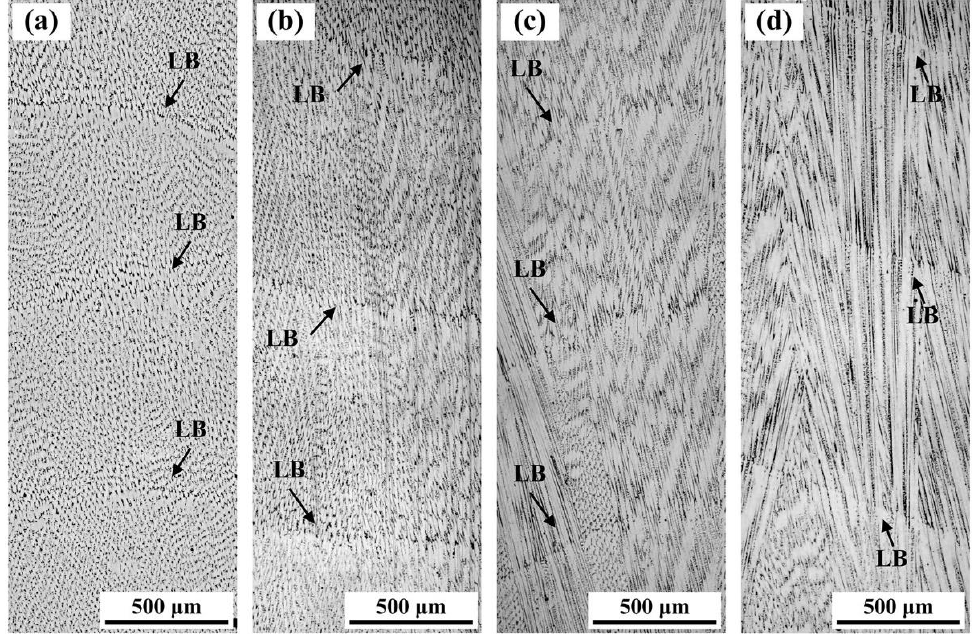
Figure 10. Microstructures of LMD-Al 0.5 FeCoCrNi walls under different heat dissipation rates by